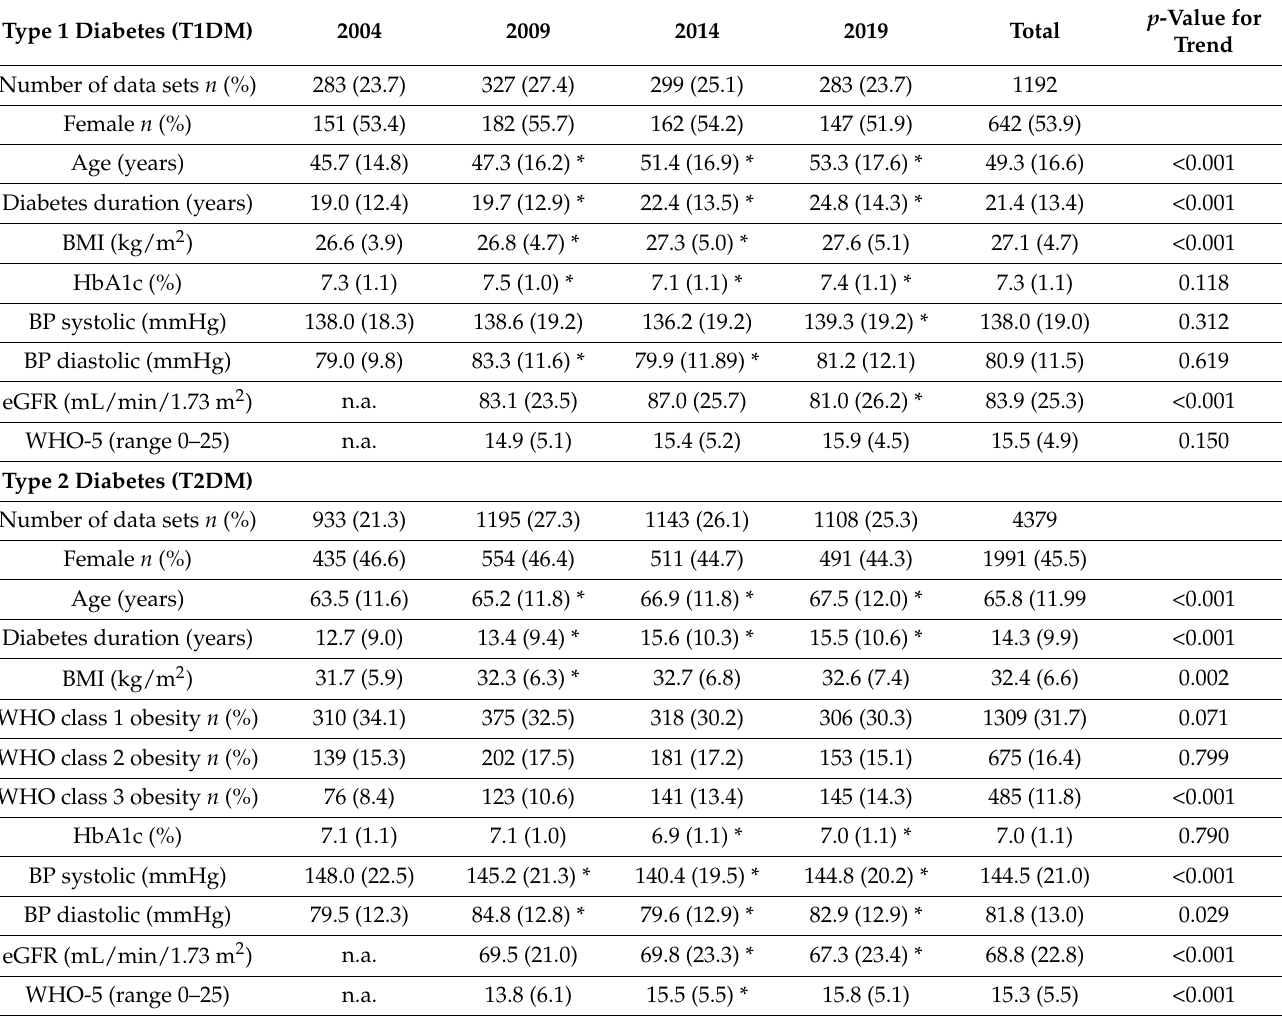
Table 1. Characteristics and metabolic control of patients in secondary care (SC).